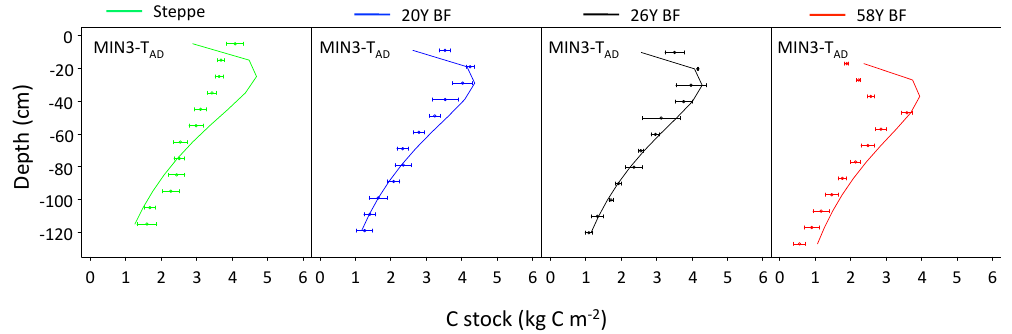
Fig. 6. Total Organic Carbon for the MIN3 transport scheme (three pools model) and the T AD transport schemes. Measured C stocks are represented by the circles and modelled C stocks by the